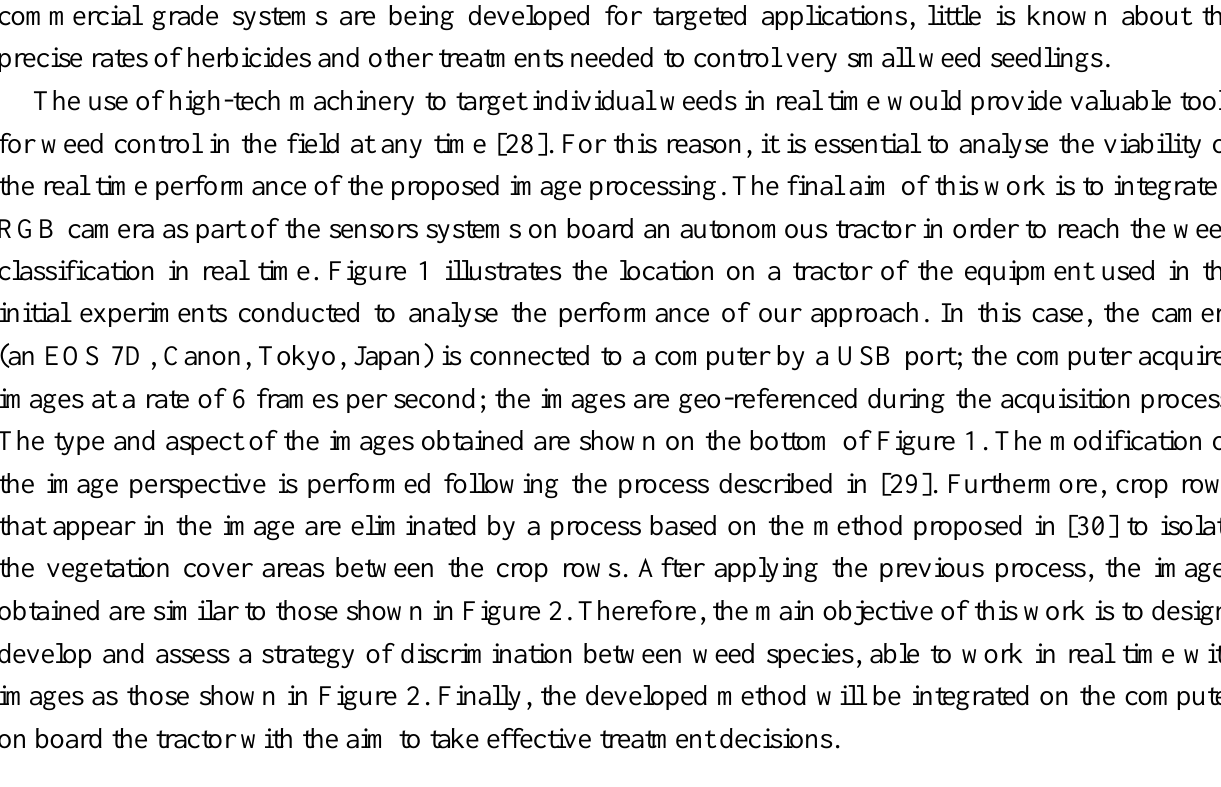
Figure 1. A RGB camera on board an autonomous tractor acquiring geo-referenced images in real conditions (lighting and tractor speed) in a maize